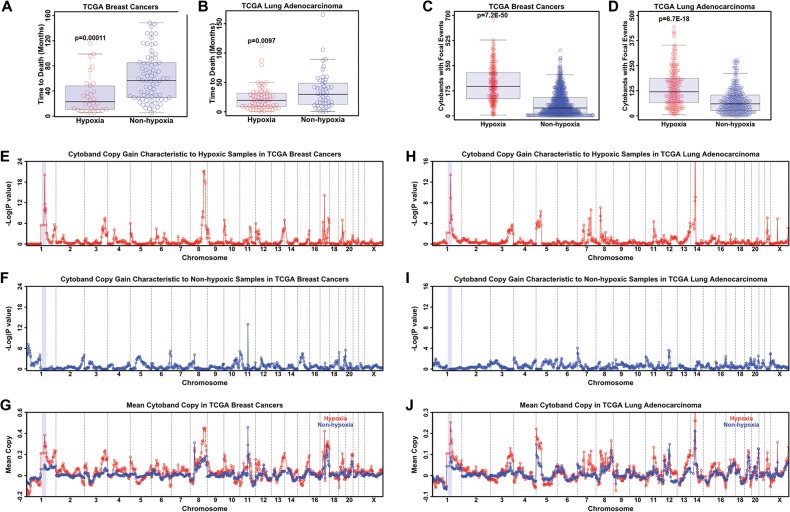
Tumors with a hypoxic signature have copy gains of regions observed in hypoxic cell culture. (A) TCGA breast cancer samples with a hypoxic gene signature have a faster time to death. (B) TCGA lung adenocarcinoma samples with a hypoxic gene signature have a faster time to death. (C) TCGA breast cancer samples with a hypoxic gene signature have increased focal CNVs. (D) TCGA lung adenocarcinoma samples with a hypoxic gene signature have increased focal CNVs. (E) TCGA breast cancer samples with a hypoxic gene signature have an enrichment of copy gain of 1p11.2 through 1q23.3. (F) TCGA breast cancer samples without a hypoxic gene signature do not have enrichment of copy gain of 1p11.2 through 1q23.3. (G) Mean copy number of hypoxic (red) and nonhypoxic (blue) breast cancer samples. (H) TCGA lung adenocarcinoma samples with a hypoxic gene signature have enriched copy gain of 1p11.2 through 1q23.3. (I) TCGA lung adenocarcinoma samples without a hypoxic gene signature do not have enriched copy gain of 1p11.2 through 1q23.3. (J) Mean copy number of hypoxic (red) and nonhypoxic (blue) lung adenocarcinoma samples. For each coamplification plot, blue shaded regions indicate 1p11.2 through 1q23.3.